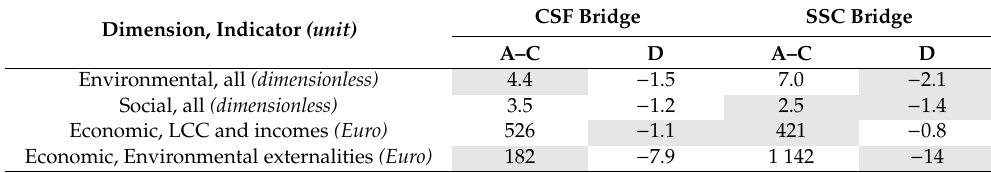
Table 8. Comparison of the design concepts for modules A–C and for module D for the functional unit. The results are aggregated at the dimension level for the environmental and social dimensions and at the indicator level for the economic dimension. The results for the environmental and social dimensions are normalized and weighted, while the results for the economic dimension are summarized. Module B8 is not included in the comparison. The best options are highlighted in